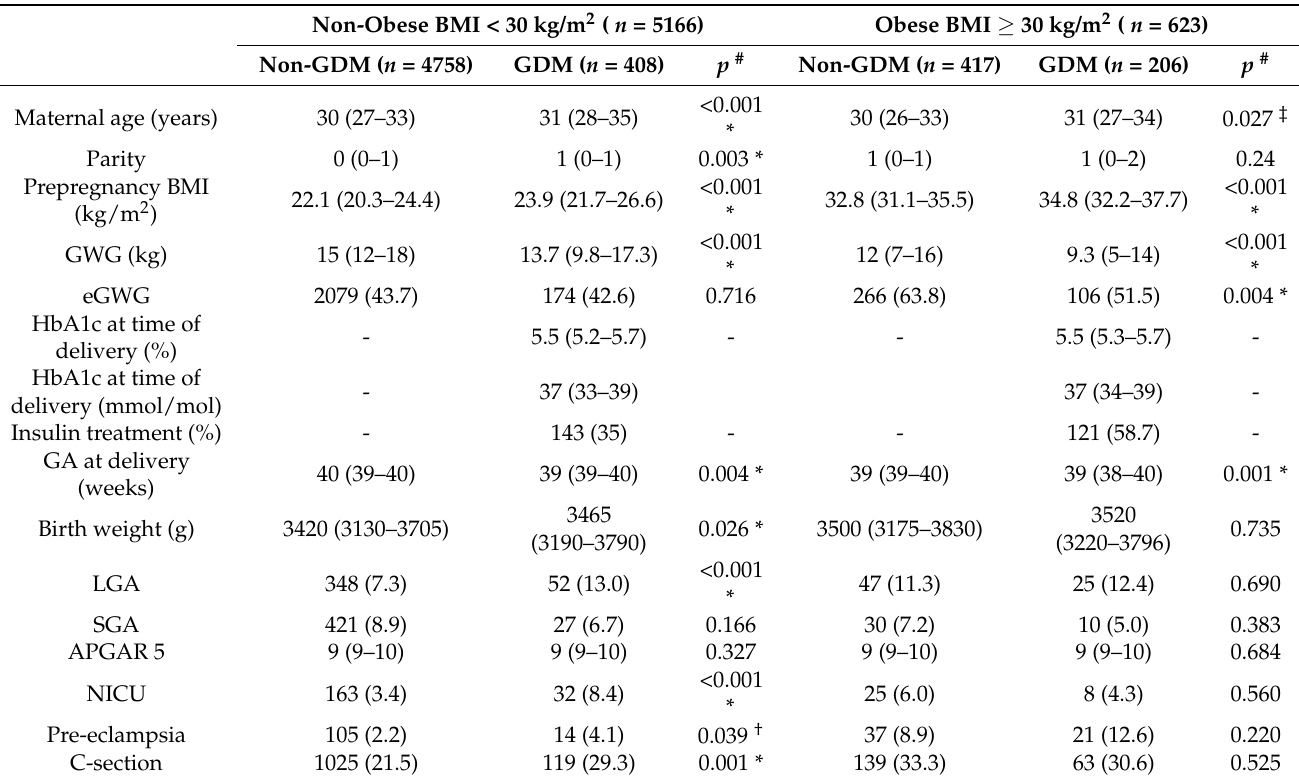
Table 3. Descriptive parameters of pregnancies with and without GDM in the non-obese (BMI < 30 kg/m 2 ) or obese (BMI 30 ≥ kg/m 2 )